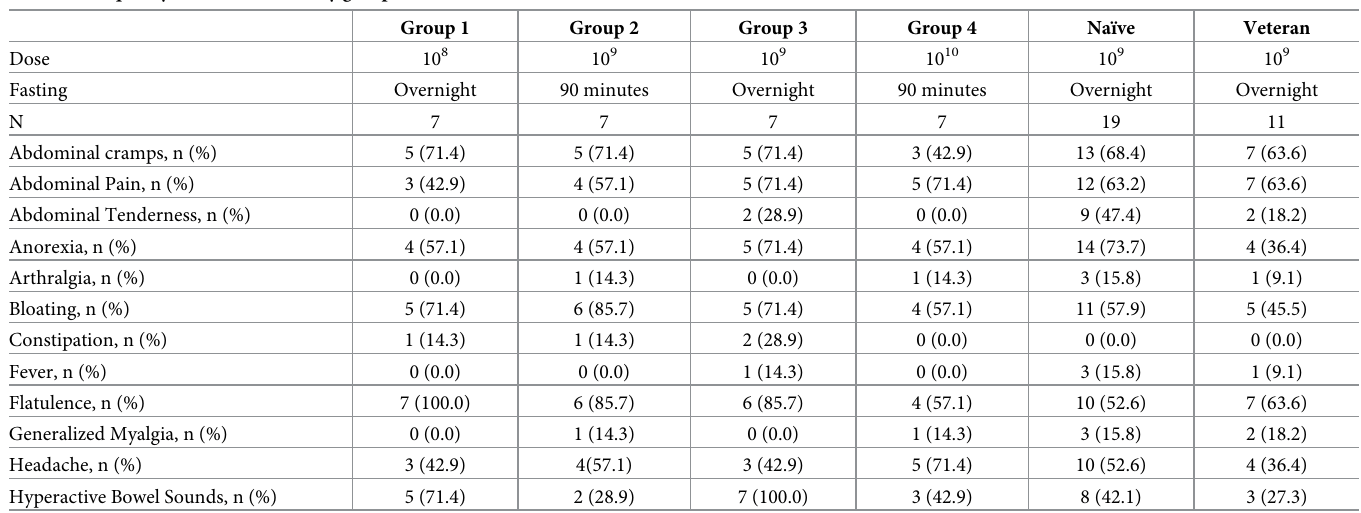
Table 2. Frequency of adverse events by group.